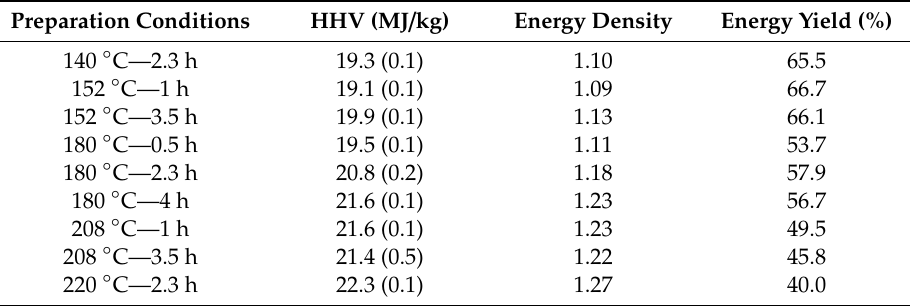
Table 4. Energy-related properties of the